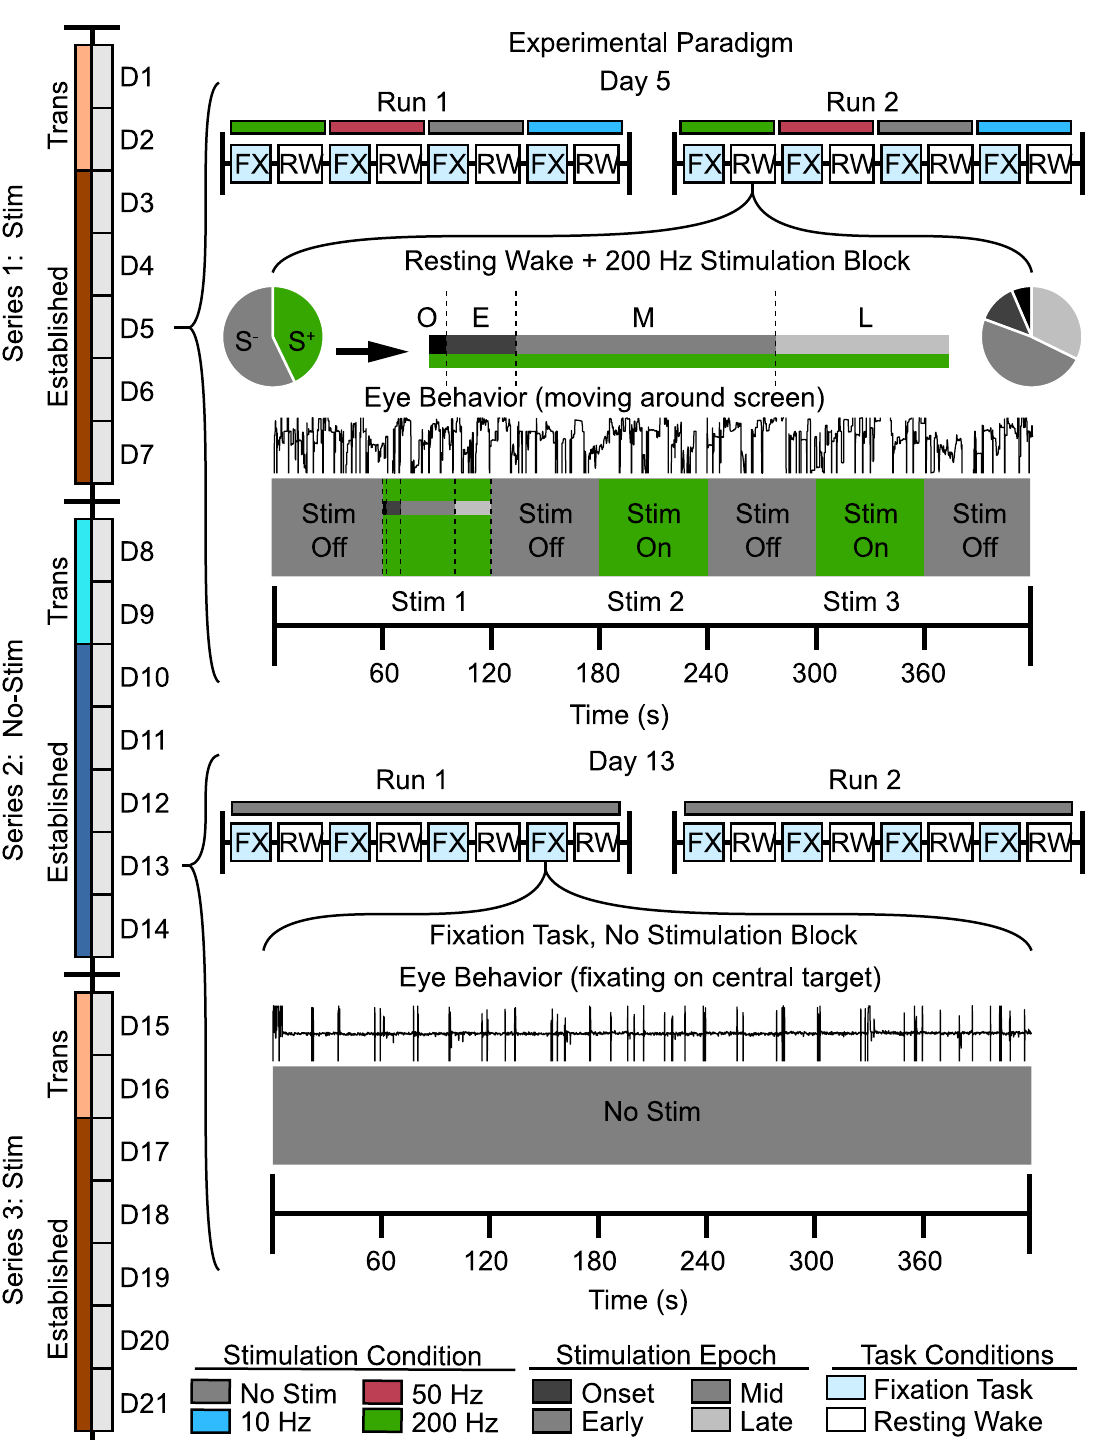
Fig 2. Experimental paradigm for manipulating consciousness in awake macaques. Schematized paradigm to reveal stimulation frequency-specific effects of thalamic DBS across multiple time scales. On the far left, a schematized timeline of the paradigm shown shifting between a series of experiments with (Stim) and without (No-Stim) DBS. The first two recording days of a series were considered transitional, and the following days in the same series were considered established. The top half of the figure presents an example day (D5) in the DBS paradigm, comprised of a pair of experimental runs with pseudorandom stimulation frequency assignment. Here, a sample resting-wake block (420s) using 200Hz DBS is featured, with typical on/off periods (S + /S - ) of DBS within the block (60s on, 60s